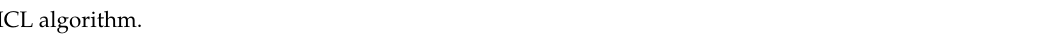
Algorithm 1: CMCL